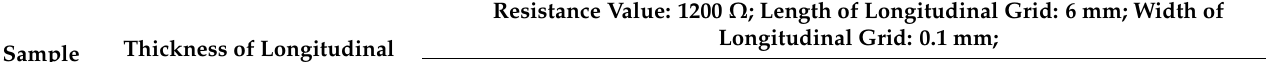
Table 4. Geometric dimensions of thin-film resistor grids with different